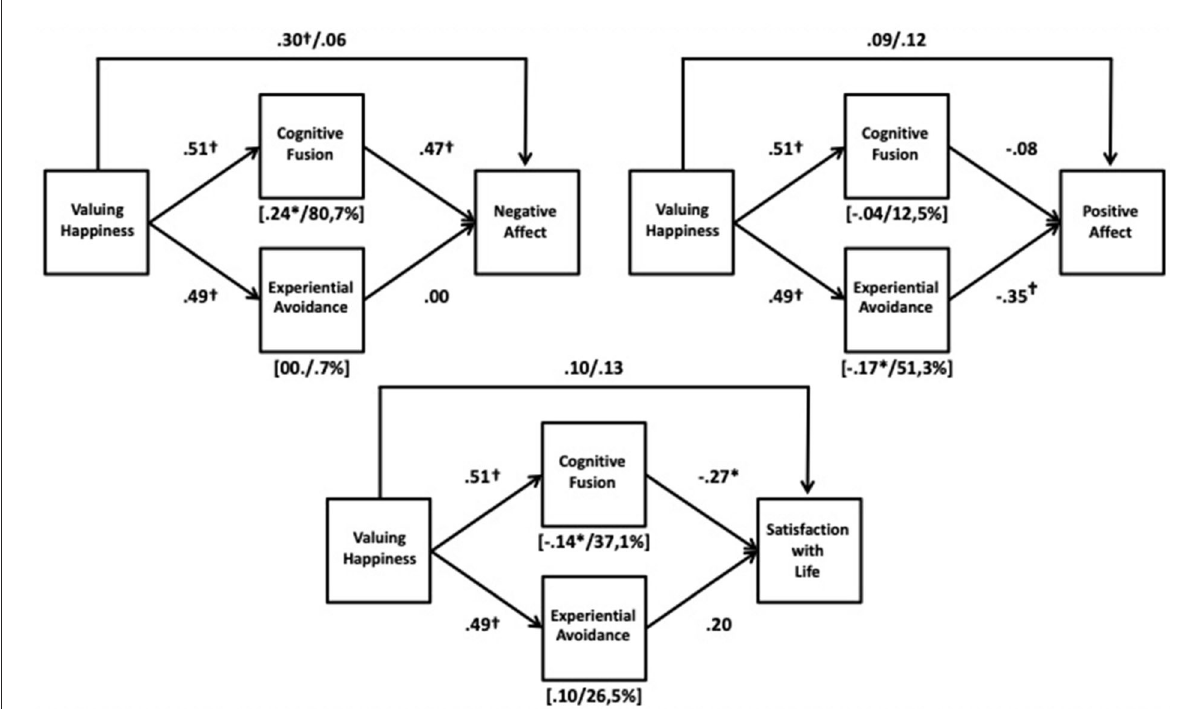
FIGURE1 Path diagrams for the mediation between valuing happiness and wellbeing variables through psychological inflexibility components. Regression coefficients were standardized values. Values that are separated by a slash above an arrow indicate total effect (left value) and direct effect (right value). Values in square brackets below a mediator and separated by a slash indicate its indirect effect (left value) and the proportion between its mediated effect and the total effect (right value). * p < 0.05; † p <